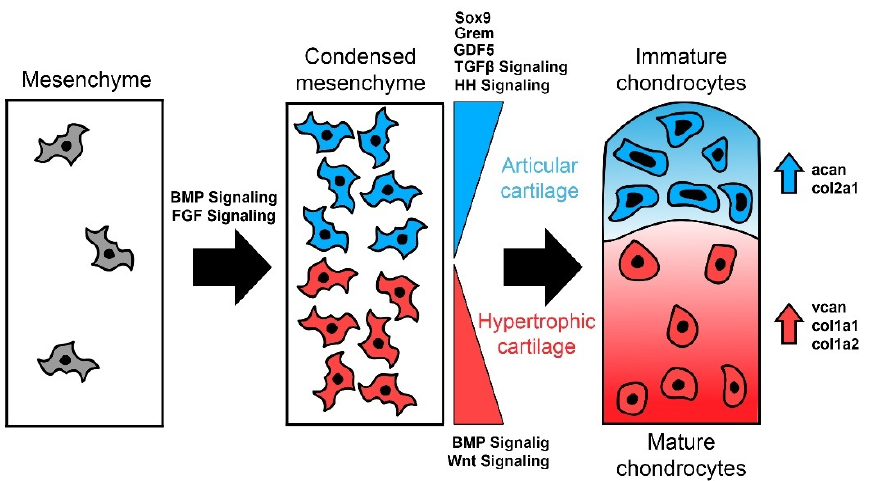
Figure 3. Differentiation of cartilage along the joint interface in osteichthyans. BMP signaling and FGF signaling contribute to initial mesenchymal condensation while genetic factors proportionally contribute to either articular and hypertrophic cartilage development. Increased TGF β and hedgehog (HH)signaling along with grem , gdf5 , and sox9 activity drive prechondrogenic mesenchyme towards the articular cartilage fate (blue), with increased expression of archetypal cartilage extracellular matrix (ECM) genes like acan and col2a1 . Conversely, increased WNT and BMP signaling drive these cells towards hypertrophy (red) and expression of bone-related ECM genes like vcan , col1a1 , col1a2 .